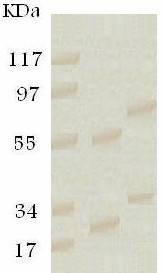
Enzyme-linked immunoelectrotransfer blot of purified Fasciola ES antigen resolved on 12.5% SDS-PAGE and probed with a pair of MoAbs against ES products. Lane 1: Low molecular weight standard. Lane 2: The 10A/9D/10G MoAb. Lane 3: The 12B/11D/3F MoAb.